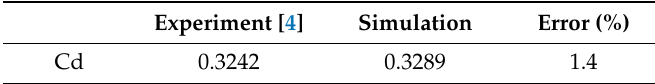
Figure 5. Mesh strategy. Table 1. Mesh quality verification.